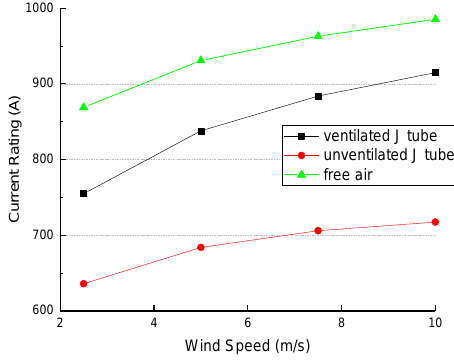
Figure 7. Comparisons of ratings at different wind speeds.